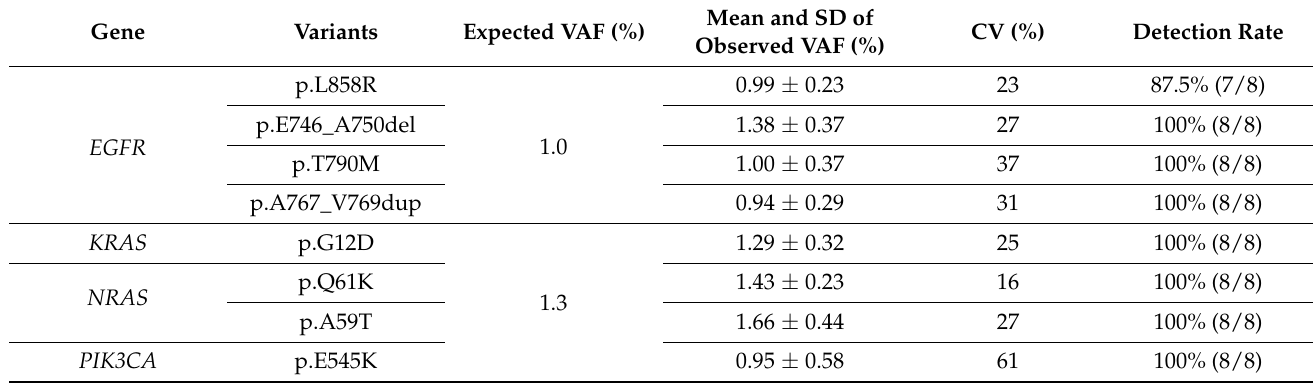
Table 3. Precision at a VAF of 1% with 20 ng of reference material when testing duplicates within the same batch and six replicates from independent batches.